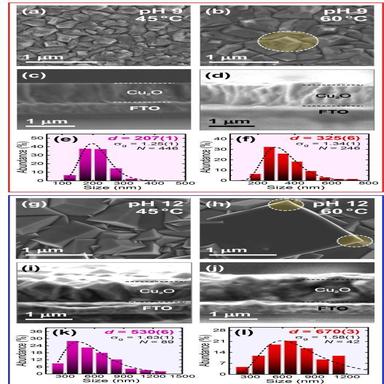
Representative top-view FE-SEM micrographs of the Cu2O thin films deposited at (a) pH 9/45 ◦C, (b) pH 9/60 ◦C, (g) pH 12/45 ◦C, and (h) pH 12/ 60 ◦C. Representative cross-section FE-SEM micrographs of the Cu2O thin films deposited at (c) pH 9/45 ◦C, (d) pH 9/60 ◦C, (i) pH 12/45 ◦C, and (j) pH 12/ 60 ◦C. Grain size distribution histograms of the Cu2O thin films deposited at (e) pH 9/45◦C, (f) pH 9/60 ◦C, (k) pH 12/45 ◦C, and (l) pH 12/60 ◦C. The distribution statistic obtained after log-normal fit (dashed li